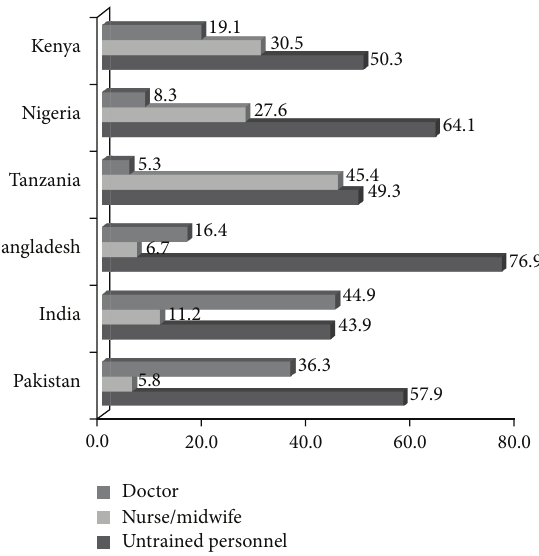
Figure 2: Percentage distribution of the type of birth attendant by